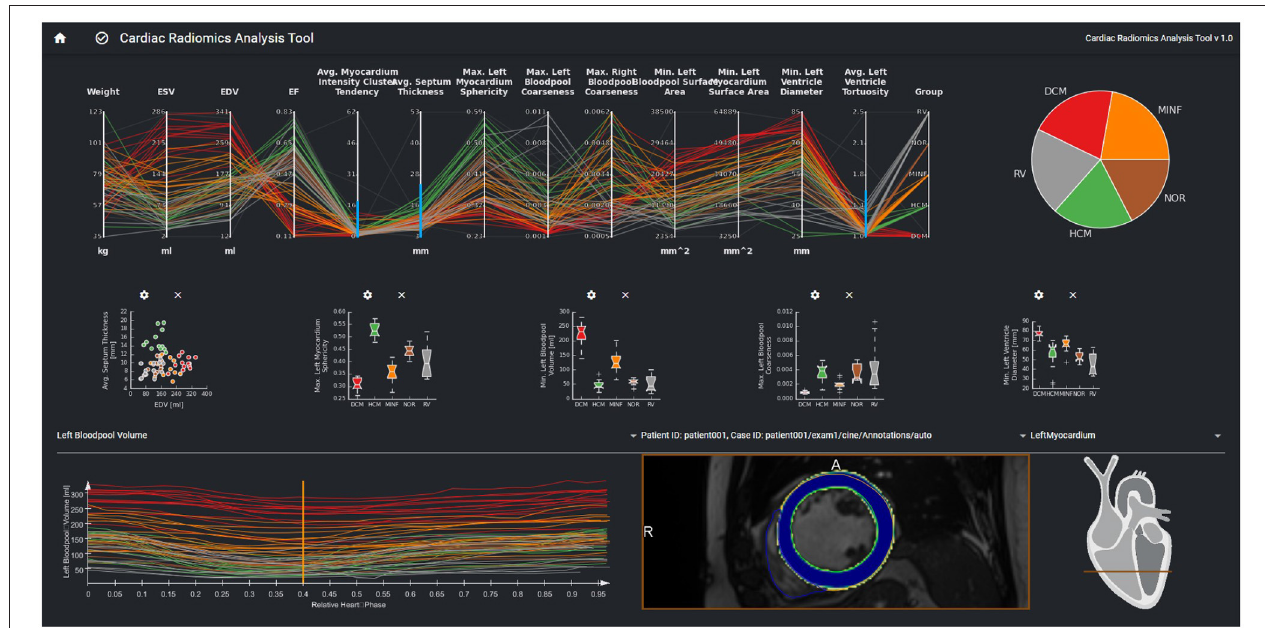
FIGURE 7 | Visual analytics of complete ACDC dataset, which consists of 100 cases. The lines in the PCP represent the patients of the underlying cohort. The color of the lines visualizes the classification result and corresponds to class color in the pie chart. The selection via the blue brushes in the PCP includes patients without outliers for features such as septum thickness, myocardium intensity cluster tendency, and left ventricle tortuosity. The scatter plot in the second row shows the EDV vs. avg. myocardium intensity cluster tendency for this cohort. In the box-plots, the distributions of max. myocardial sphericity, max. LV volume and left ventricular diameters in each disease subgroup are shown. The curve diagram shows the LV blood pool curve of each patient over the cardiac cycle.